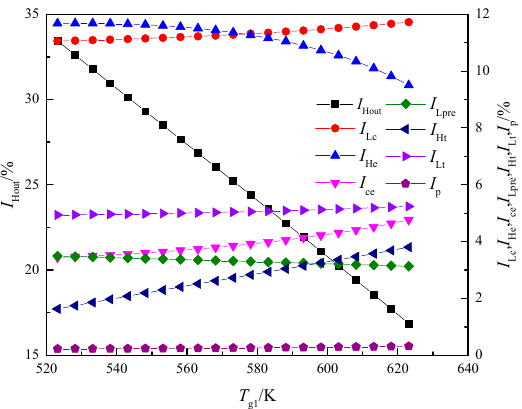
Figure 17. Effects of T g1 on exergy destruction rate for the toluene system.